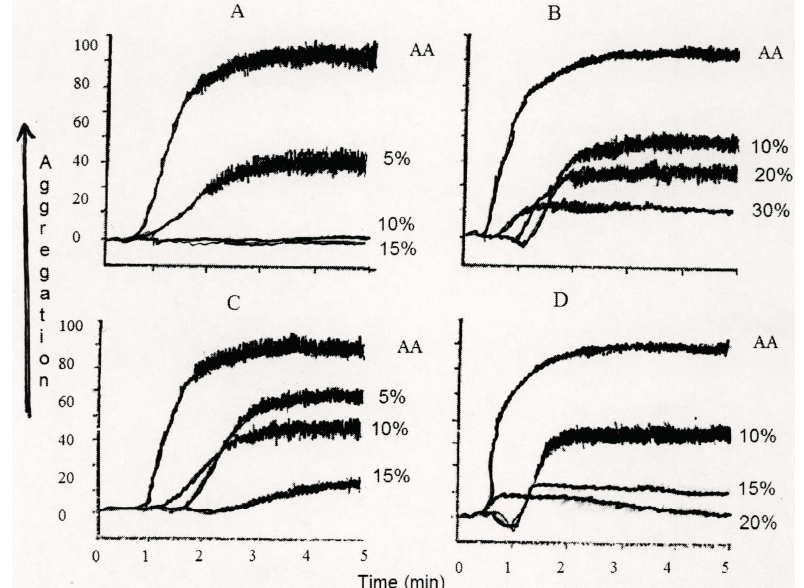
Figure 1. Effects of plasma from cat ( A ), baboon ( B ), bovine ( C ) and dog ( D ) on AA-induced platelet aggregation. N